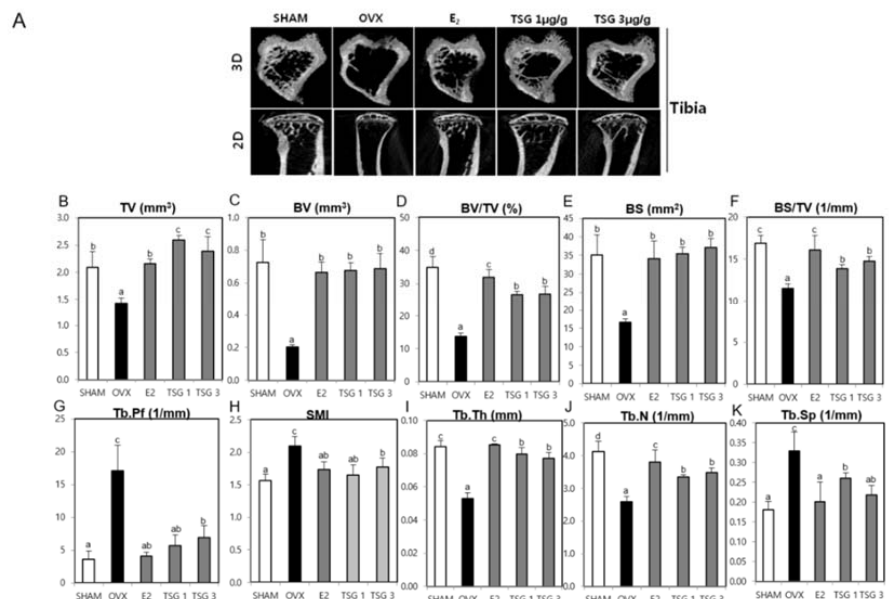
Figure 6. Effect of TSG on trabecular morphometric parameters in the proximal tibia of the C3H/HeN mice. The mice were treated with vehicle and TSG (1 and 3 μ g/g/day, IP) for six weeks. ( A ) Representative two ‐ dimensional (2D) images and three dimensional (3D) images of the tibia epiphysis, ( B ) tissue volume (TV), ( C ) bone volume (BV), ( D ) bone volume/tissue volume, ( E ) bone surface, ( F ) bone surface/tissue volume, ( G ) trabecular pattern factor, ( H ) structure model index, ( I )